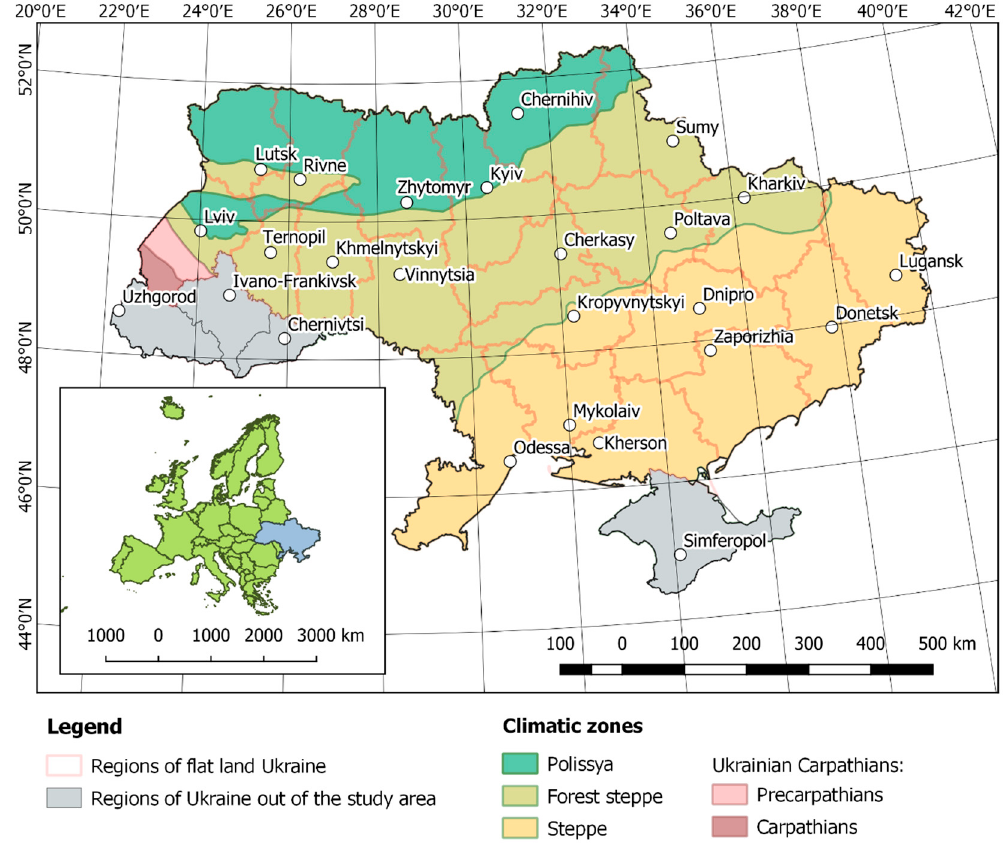
Figure 1. The study area representing three main climatic zones of flatland Ukraine.